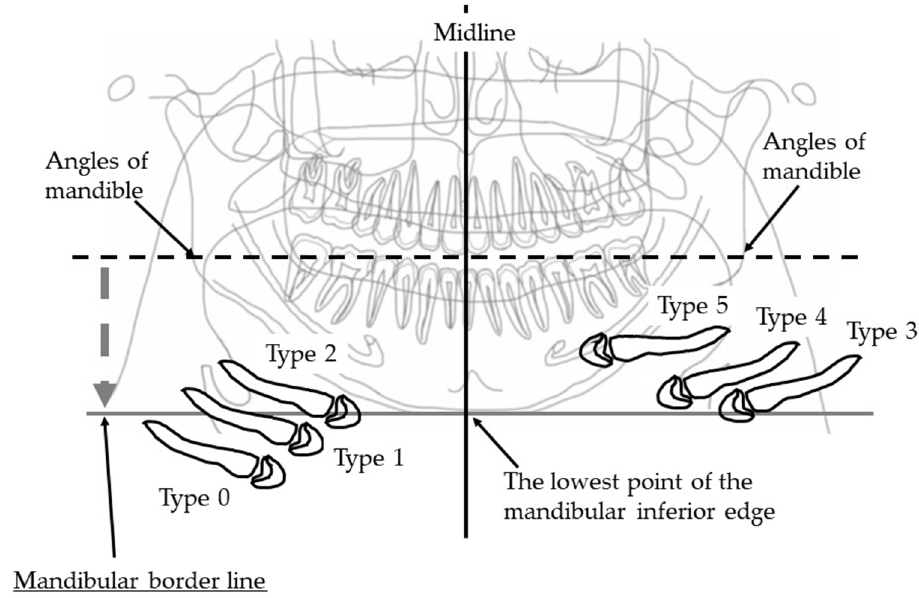
Figure 1. Vertical hyoid bone position. Mandibular border line was defined as a line that moves virtual line which is connecting the both side of mandibular angles, in parallel along the center line and attach to the lowest point of the mandibular inferior edge. An evaluation was conducted of the extent to which the hyoid body and greater horn appeared in the upper area from the mandibular border line.